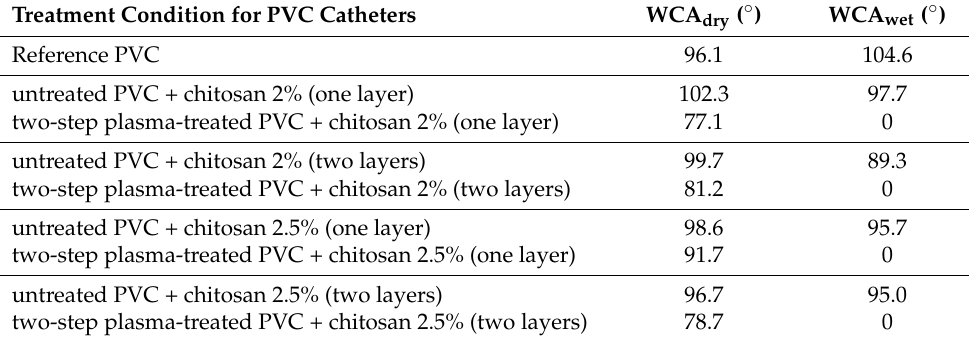
Table 9. Water contact angle (WCA) of PVC catheters with the coatings. Treatment Condition for PVC